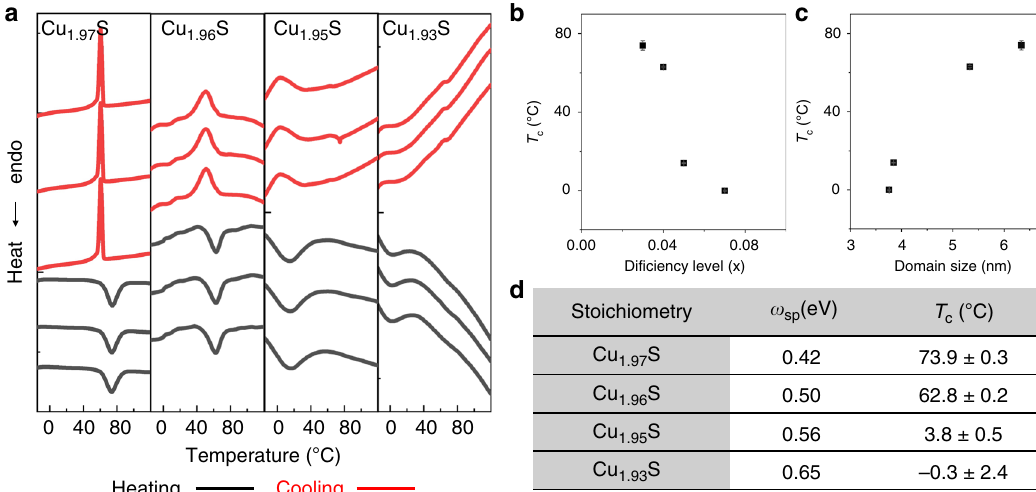
Fig. 6 Effect of twinning on phase transition characteristics. a DSC thermograms of ca. 7 nm diameter Cu 2 − x S NCs of four levels of sub-stoichiometry. In each case, thermograms from three consecutive heating – cooling cycles performed on the same sample of NCs are shown, from which the reproducibility of the phase-transition peaks (dips) is evident. The thermograms are vertically offset for stacking. The peak temperature of the phase-transition in the heating sub-cycle was averaged across the three cycles to yield T c and the standard deviation in T c . T c plotted as a function of b the Cu-de fi ciency level, x , and c the domain size determined from PXRD. Error bars representing the standard deviation are shown for each data-point; but they are not resolvable in cases where the standard deviation is small. d Table of characteristics of the Cu 2- x S NCs as a function of the de fi ciency level. Values of ω sp correspond the LSPR peak maxima from Fig. 1a. The tabulated T c values represent the average ± standard deviation, also plotted in b , c . The analysis described here was conducted for several batches of NCs and the variability in ω sp , stoichiometry, and T c was determined (see Supplementary Table